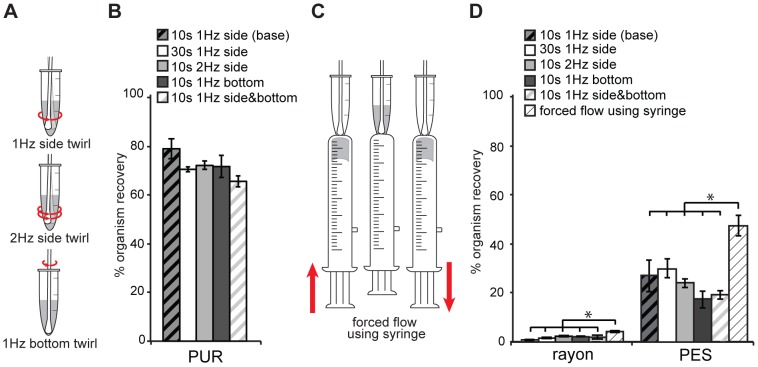
Comparison of manual agitation methods for swab transfer.(A) Schematic of action performed over a period of 1 second for different manual twirling methods. (B) Comparison of % organism recovery of PUR swabs using different twirling methods, which was calculated using Equation 5 in the text. (C) Schematic of the new forced flow syringe method. (D) Comparison of % organism recovery for PES and rayon swabs, using different twirling methods and the forced flow syringe method. * indicates statistically significant differences (Tukey-Kramer, α = 0.05).